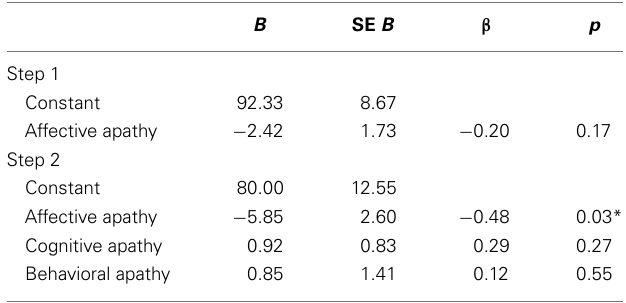
Table 5 |Apathy and emotion recognition on the Emotion Hexagon test .